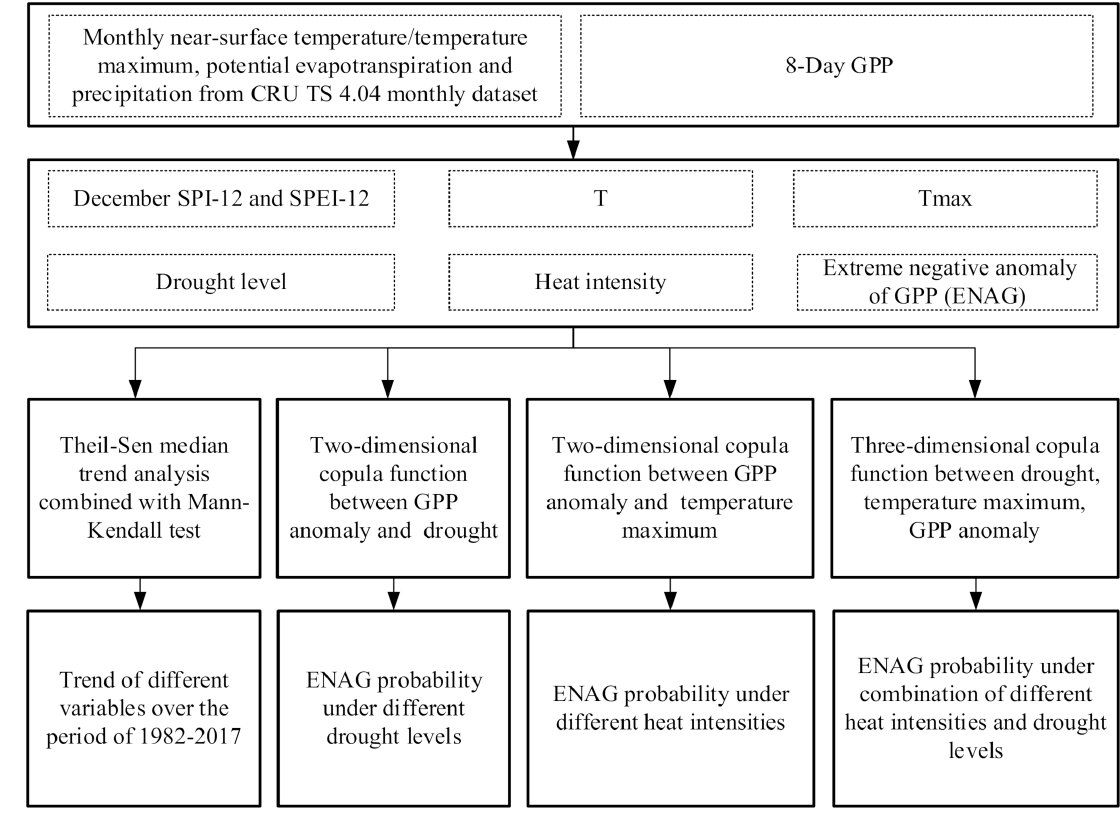
Figure 2. Technical flowchart of the study. CRU TS: University of East Anglia Climatic Research Unit (CRU) Time-Series (TS); GPP: gross primary production; SPI: standardized precipitation index; SPEI: standardized precipitation evapotranspiration index; T: yearly average of the near-surface daily mean temperature; Tmax: the maximum of the monthly average daily maximum temperature of each